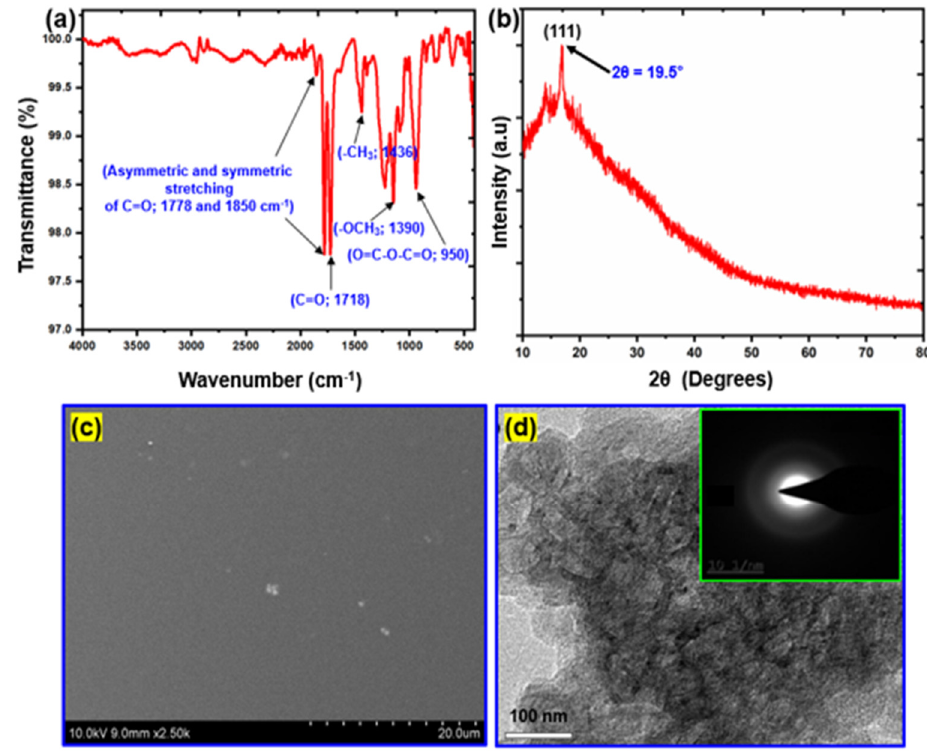
Figure 4. Structural and morphological characterizations of P(MMA- co -MA) copolymer: ( a ) FTIR spectrum; ( b ) XRD pattern; ( c ) SEM; and ( d ) TEM images (inset in d is the SAED pattern).